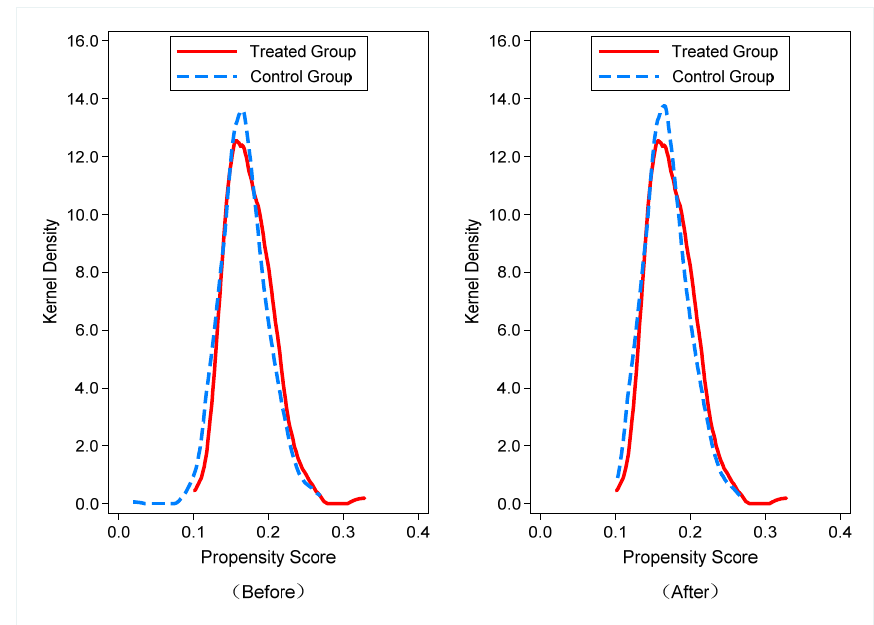
Figure 2. The probability density of the propensity scores.